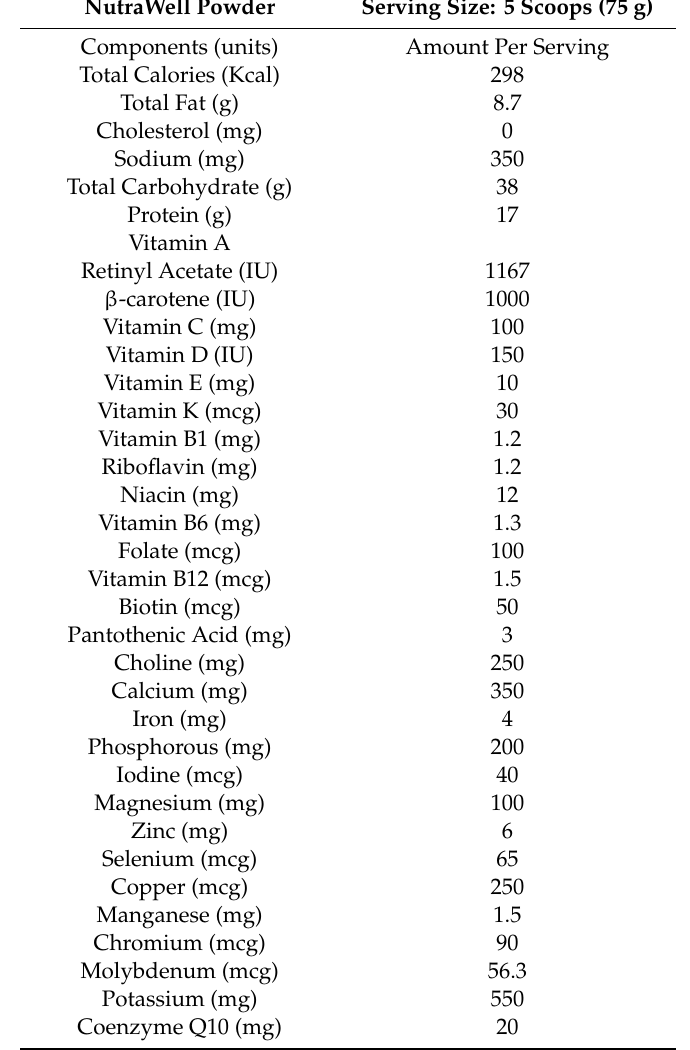
Table 1. Major components of the trial total nutritional formula (Nutrawell)